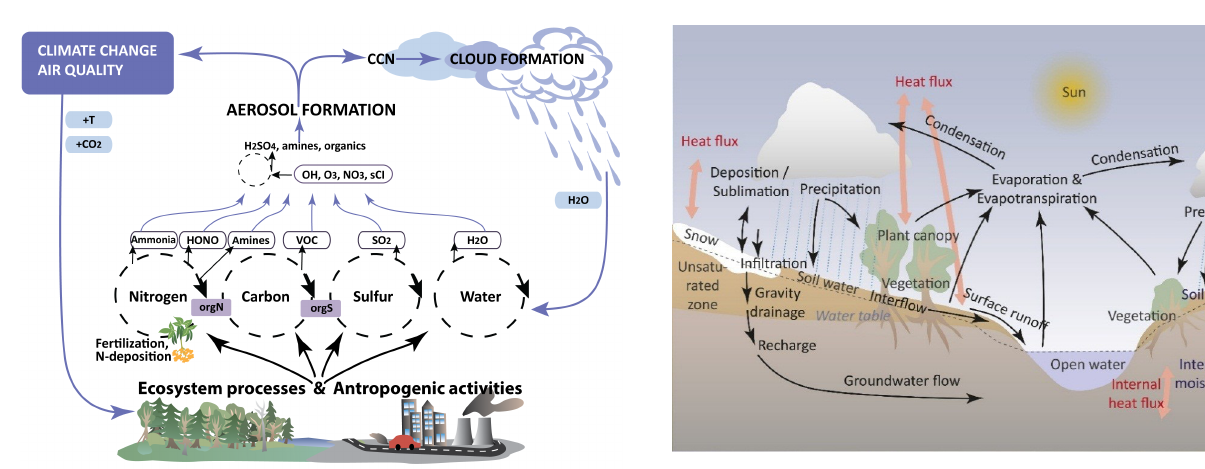
Figure 4. In urban and industrialized regions, the process under- standing of biogeochemical cycles includes anthropogenic sources, such as industry and fertilizers, as essential parts of the biogeochem- ical cycles.